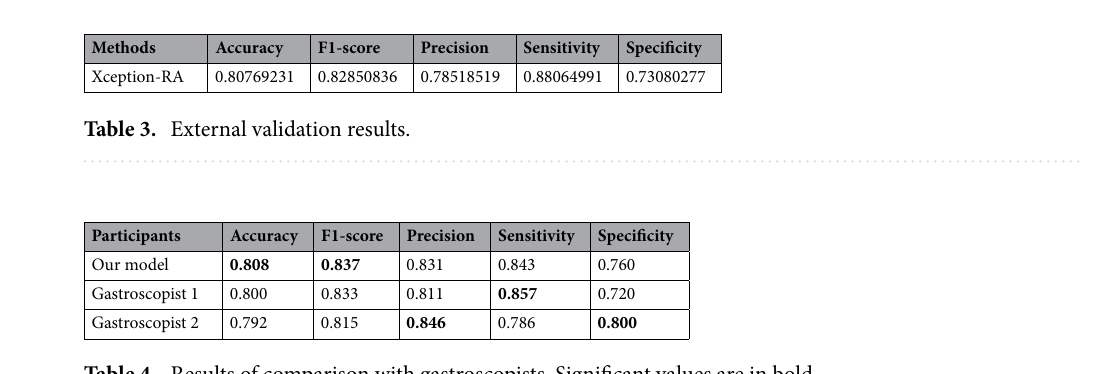
Table 4. Results of comparison with gastroscopists. Significant values are in